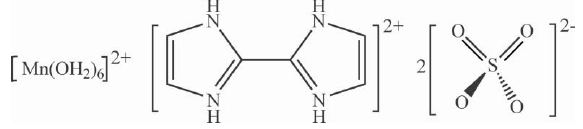
Experimental Crystal data